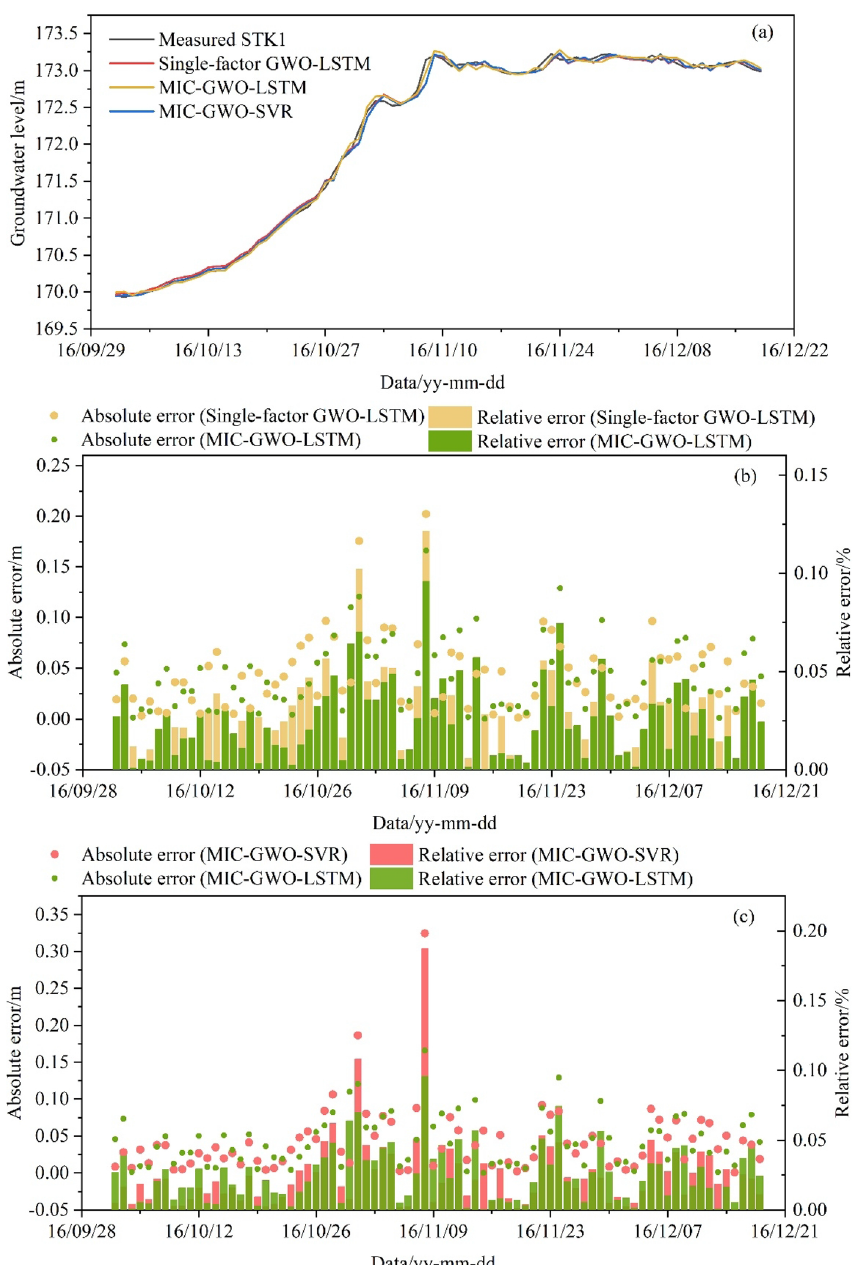
Figure 16. Prediction result of the test set. ( a ) Direct prediction of the GWL by the LSTM and SVR models, ( b ) the absolute error and relative error of the Single-factor GWO-LSTM model and the MIC-GWO-LSTM model, ( c ) the absolute error and relative error of the MIC-GWO-SVR model and the MIC-GWO-LSTM